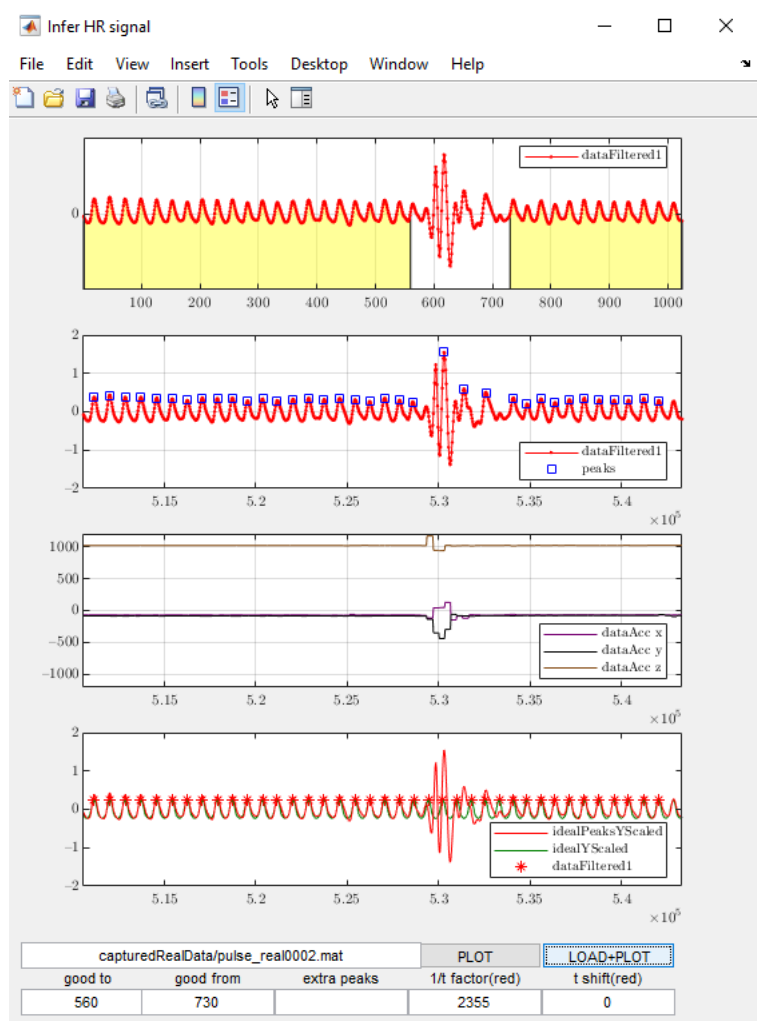
Figure 3. Application for manual selection of undisturbed parts of the signals. Time Window A and Time Window B are marked in yellow in the top graph. The fields “good to” and “good from” at the bottom of the GUI window denote the sample number at the end of Time Window A and at the start of Time Window B, respectively.